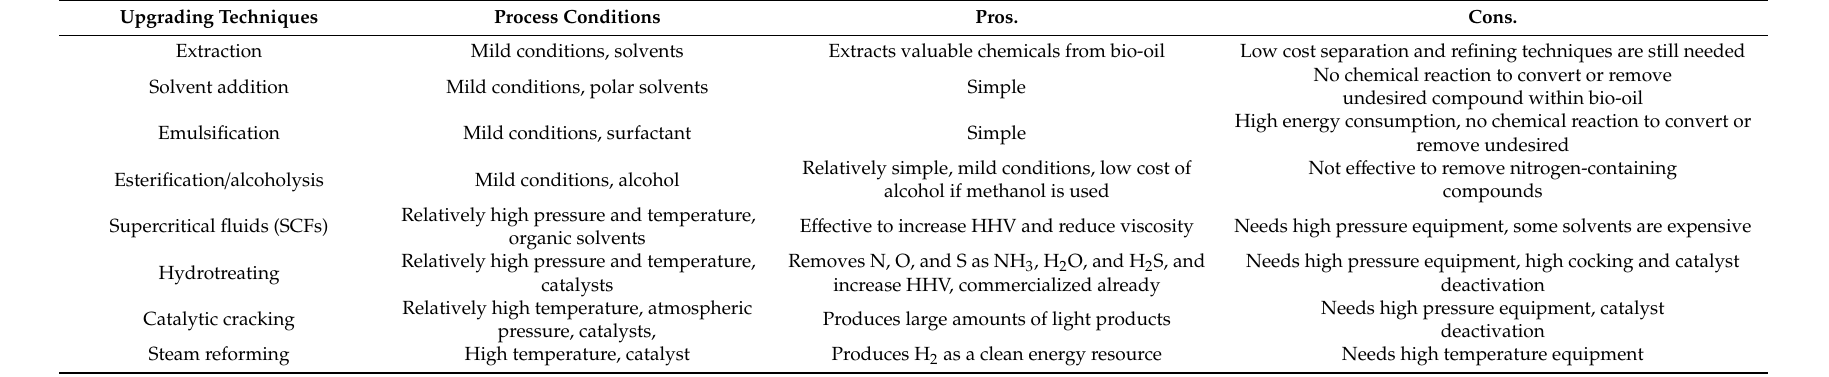
Table 7. Brief description of bio-oil upgrading